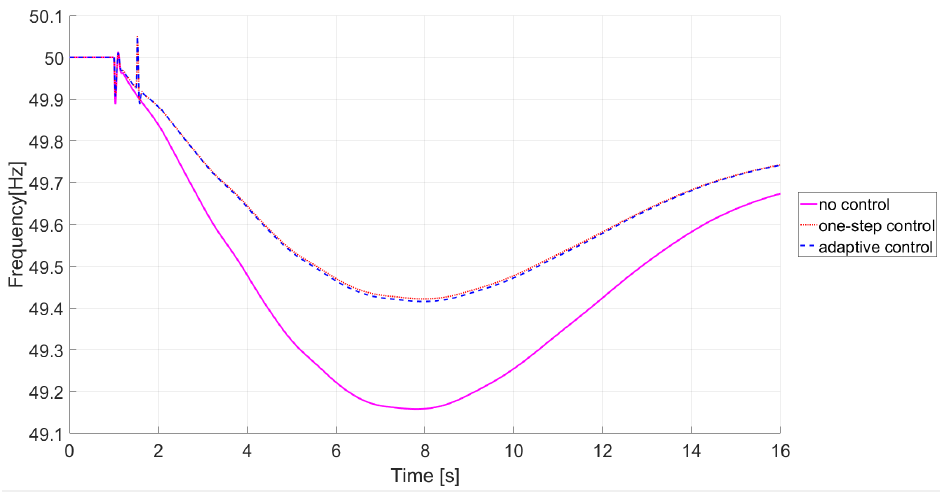
Figure 15. Frequency at bus 39 in Configuration I in case of small disturbance.